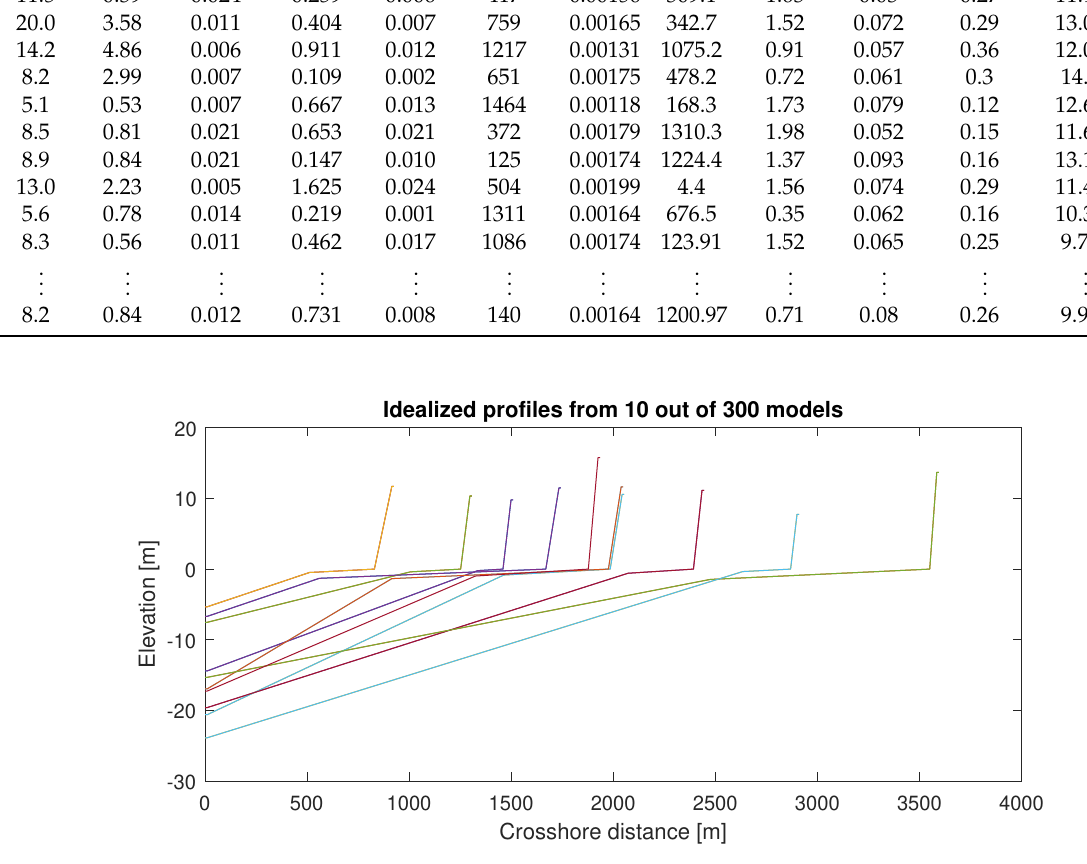
Figure 11. Sampled profiles